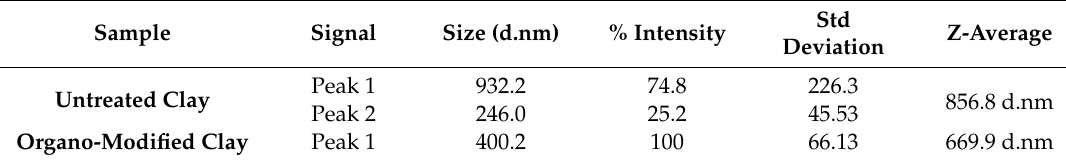
Figure 3. Particle size analysis of pure montmorillonite clay and organo modified MMT clay. Table 1. Particle size analysis of untreated and organo modified MMT clay.